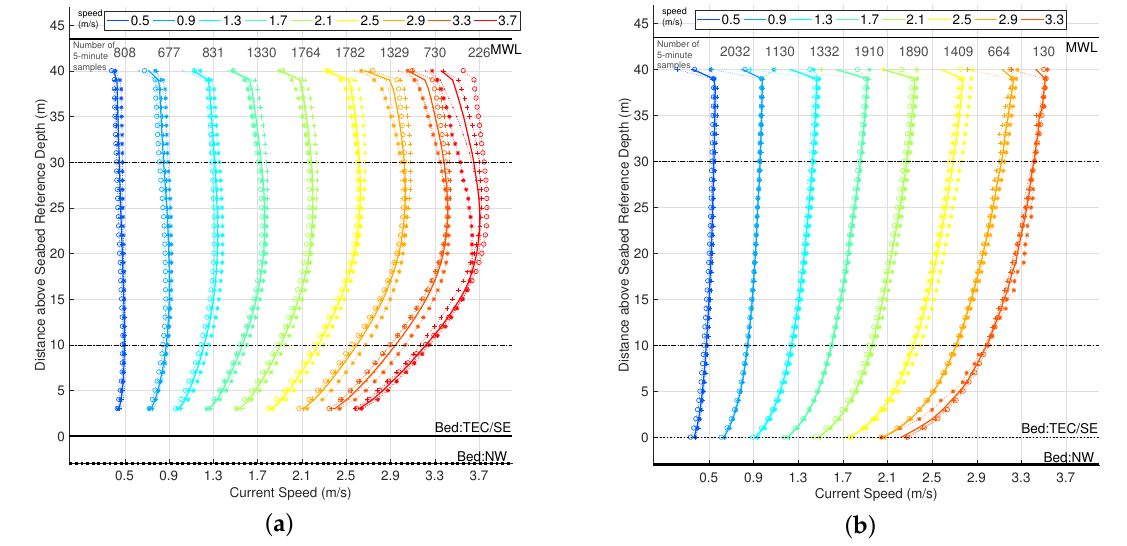
Figure 8. Depth profiles of streamwise velocity for ( a ) ebb tide and ( b ) flood tide. Measurements from individual deployments are shown with distinct markers. Solid lines without markers present the average flow speed across instruments for a given speed bin. ( a ) Ebb tide streamwise velocity depth profiles. ( b ) Flood tide streamwise velocity depth profiles.